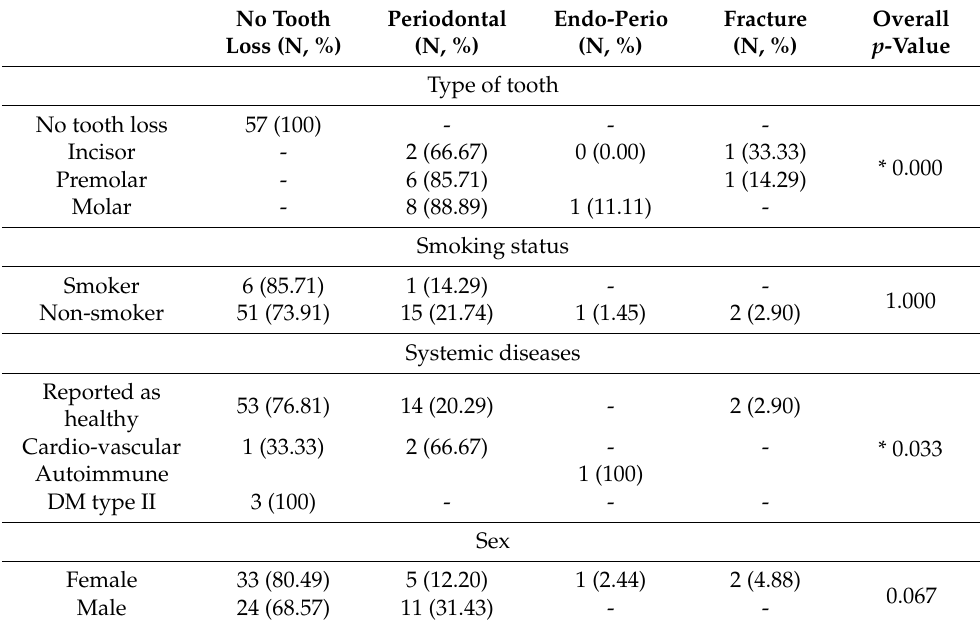
Table 3. Characteristics of teeth and population related to causes underlying tooth loss during